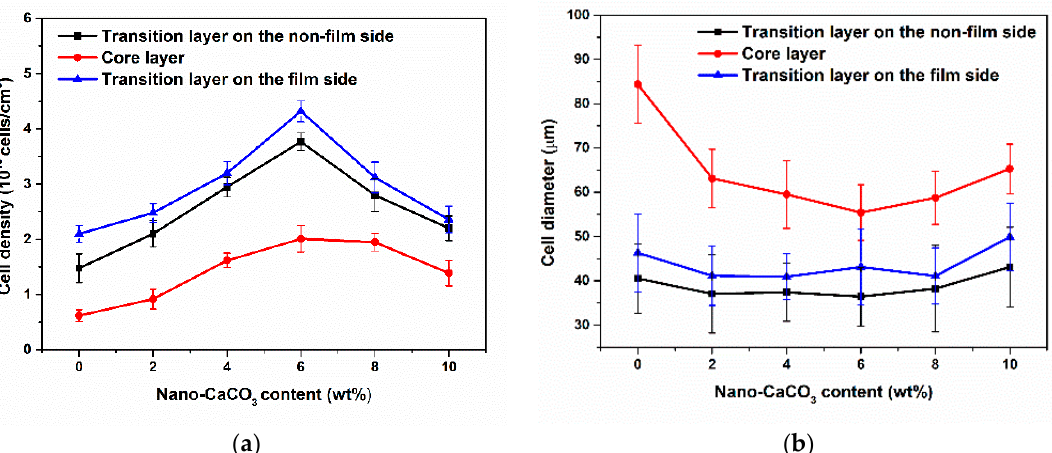
Figure 11. Cell size distribution of vertical sections with different nano-CaCO 3 content: ( a ) 0 wt %; ( b ) 2 wt %; ( c ) 4 wt %; ( d ) 6 wt %; ( e ) 8 wt %; ( f ) 10 wt %.